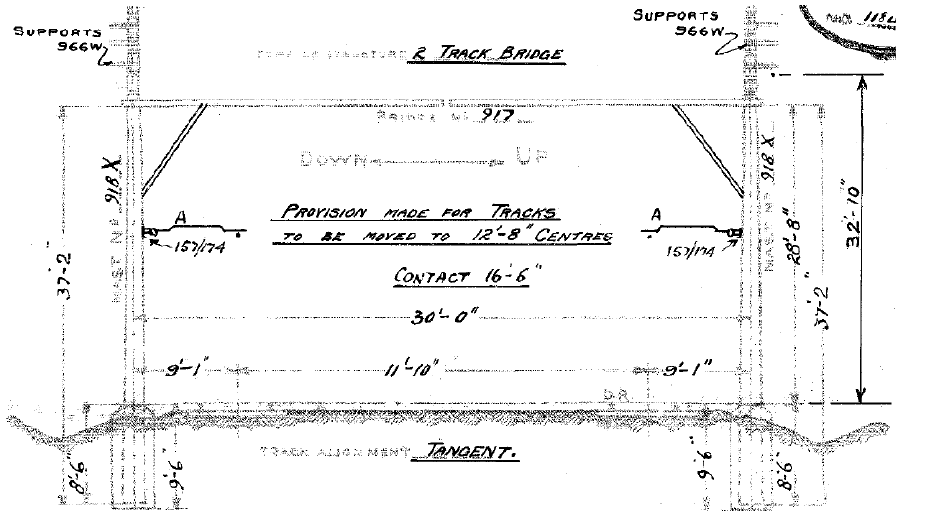
Figure 10. Original drawing in the 1910s.